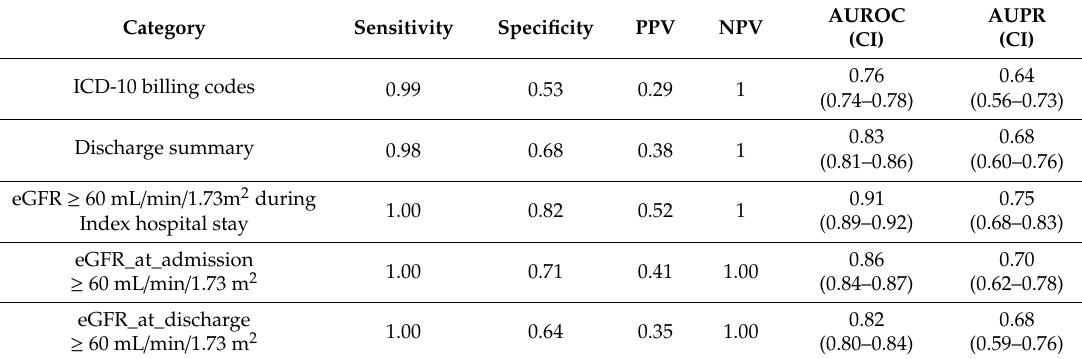
Table 5. Performance of di ff erent rules for identification of patients with NKD compared to the reference